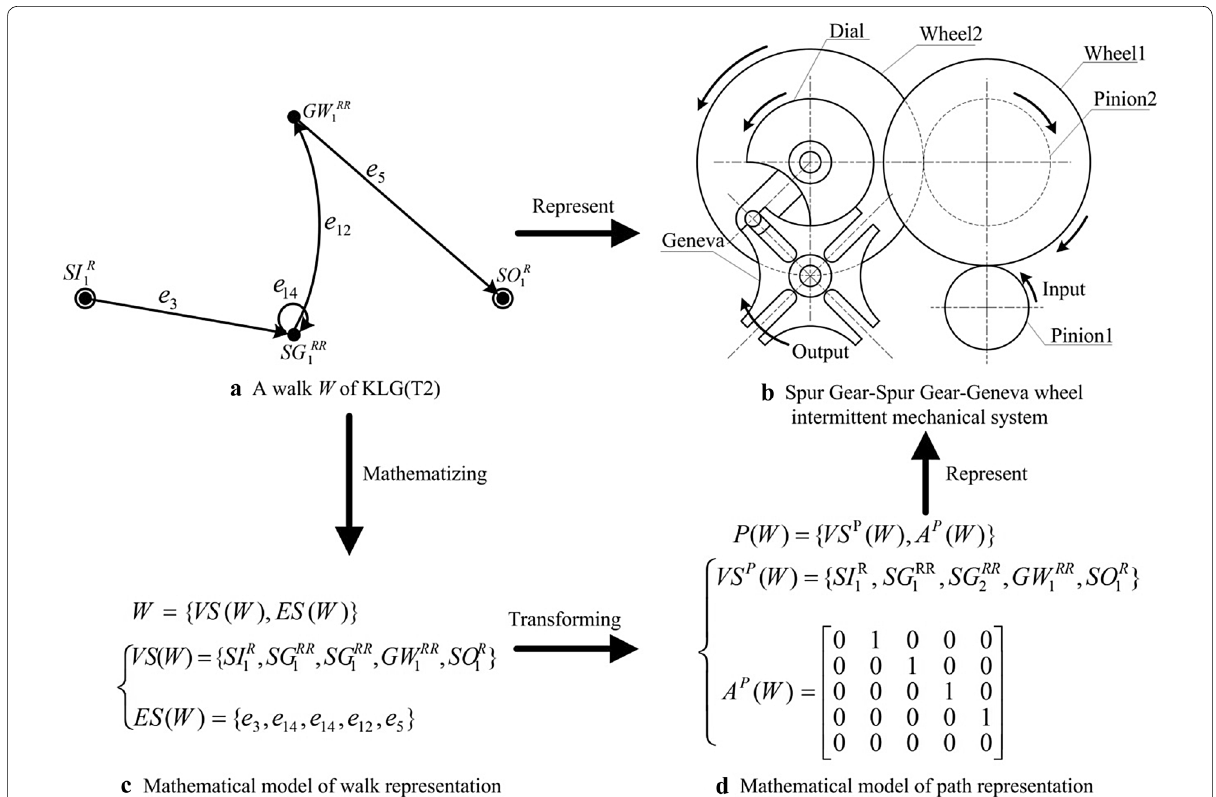
Figure 4 Relationship between the walk representation and path representation of a mechanical